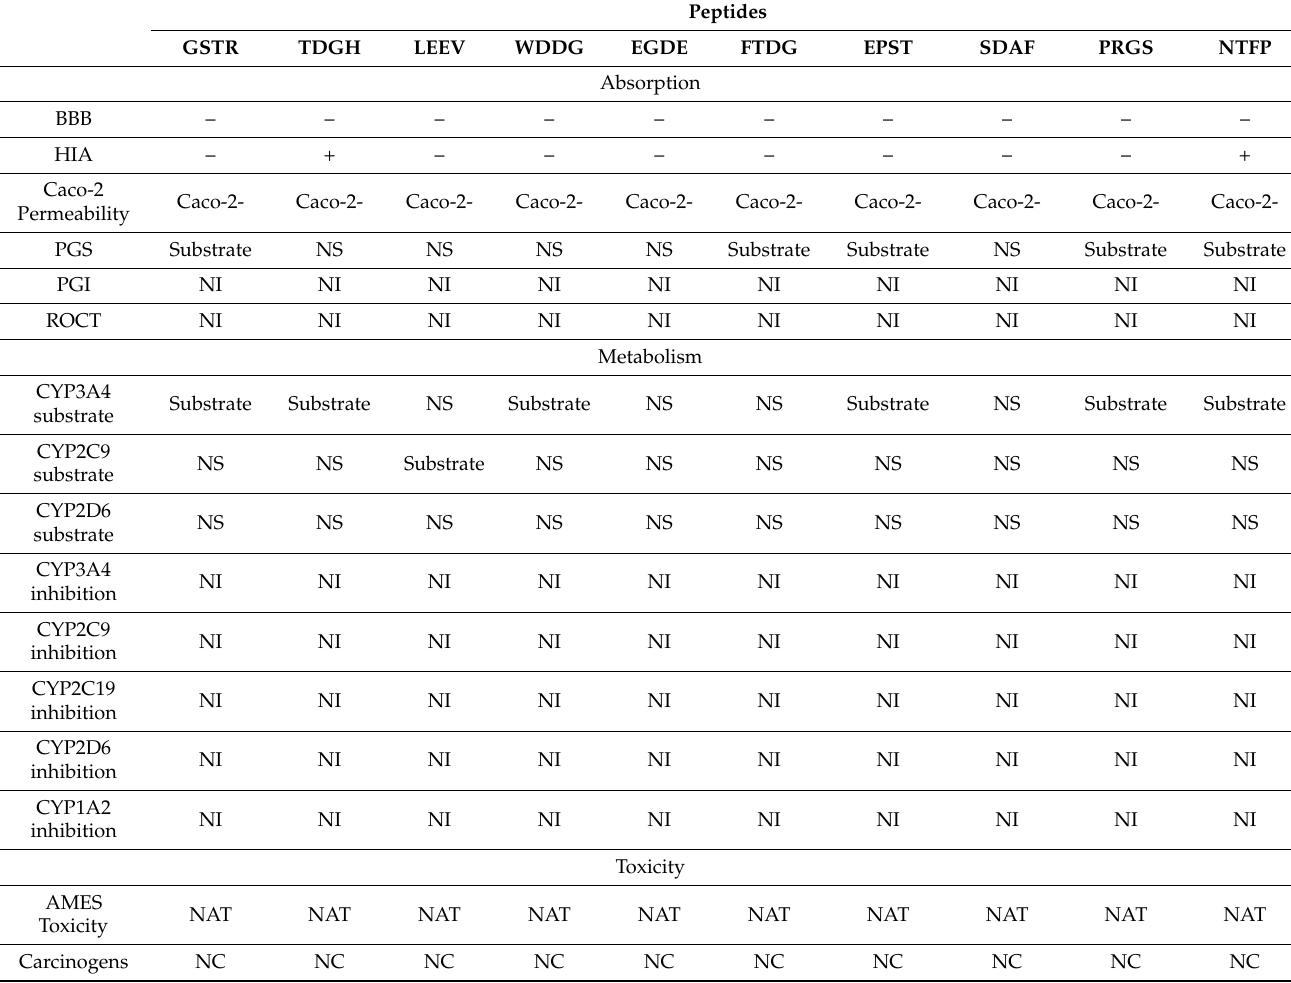
Table 3. ADMET related drug-like parameters of the best selected